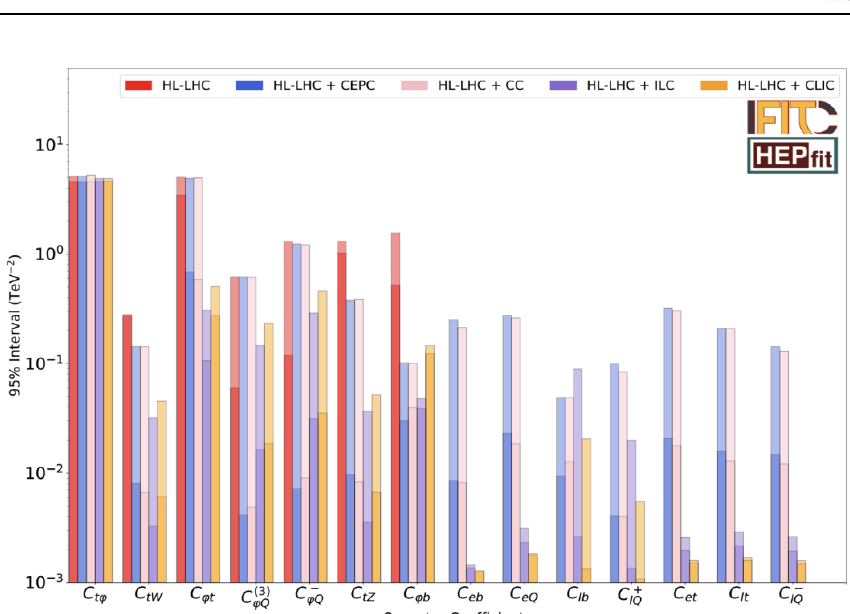
Figure 28. Comparison of expected 95% confidence intervals combining data from the HL-LHC with data from several proposed lepton collider experiments [59]. qq tt and C tG coefficients are not shown in the figure as e + e − collider measurements provide no additional sensitivity; however, all operators are included in the global fit. The solid bars show the constraint of from the single parameter fits, while the translucent bars show the marginalised constraints from the global fit. N.B. label HL-LHC + CC refers to the addition of FCC